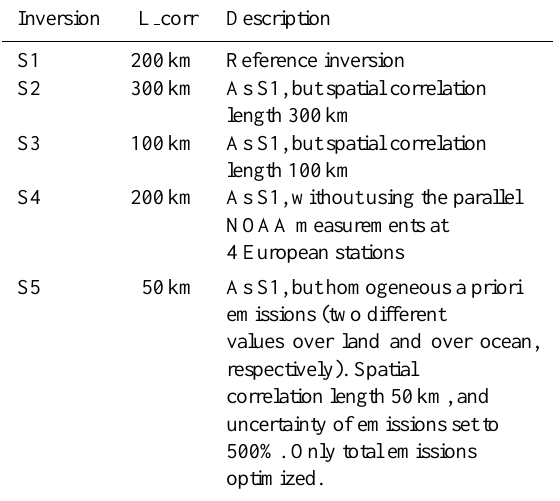
Table 4. List of the experiments described in this work. L corr denotes the spatial correlation length applied for the